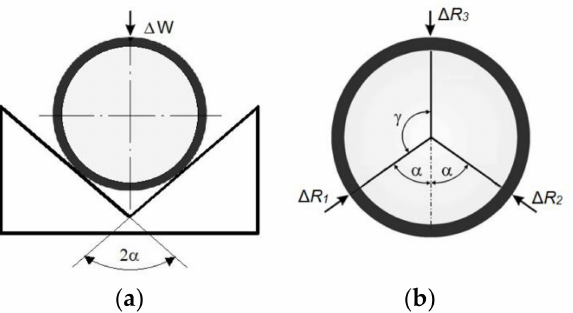
Figure 5. Three-point roundness assessment: ( a ) with the V-block method; ( b ) with the three-point floating gauge